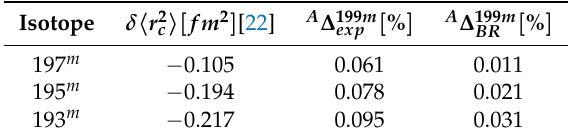
Table 11. Experimental HFA for I = 13/2 isotopes compared with the